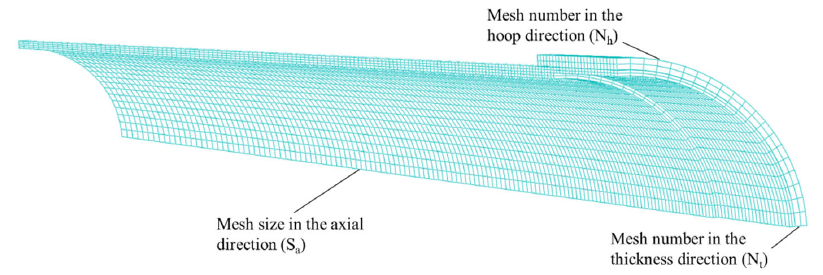
Figure 10. Schematic diagram of meshing.